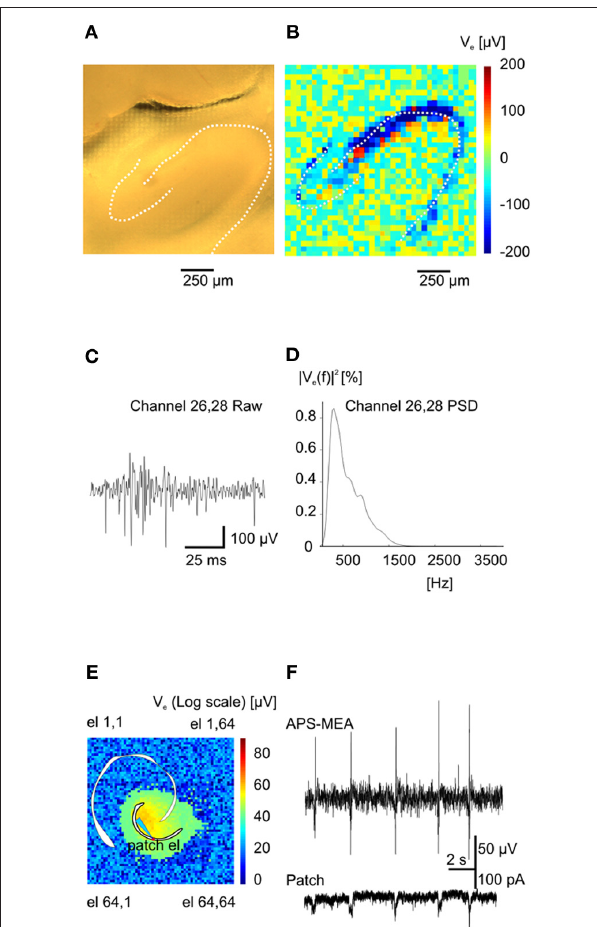
FIGURE 2 | Functional imaging of high frequency (action potentials) and low frequency events (Inter-Ictals). (A) Hippocampal slice over the recording area. (B) Absolute maximum values of an action potential train (burst) at the various electrodes. (C) Burst event recorded on electrode 26–28. (D) Power spectral density for the same electrode. (E) Color-coded map of maximum activity of spontaneous epileptic-form events. The light-blue electrode is indicating the position of the patched cell whereas the red circle is indicating the correspondent pixel. (F) Simultaneous recording of extracellular activity with one pixel of the APS-MEA (top trace) and intracellular activity with a patch electrode (bottom